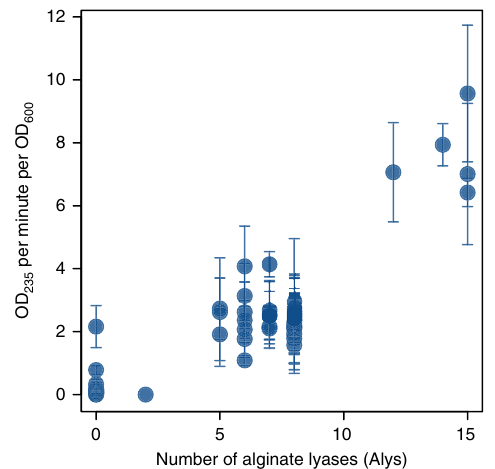
Figure 2 | Alginate lyase activity is modulated by gene dosage. Isolates were grown in marine broth with added alginate oligosaccharides to induce enzyme expression. The cells were lysed to determine the total, cell associated alginate lyase activity by measuring the increase of absorption at 235nm with alginate as enzyme substrate. The alginate lyase activity of each strain was normalized against the optical density of the respective cell culture measured at 600nm. The experiment was carried out in triplicate and the error bars display the standard deviation of the